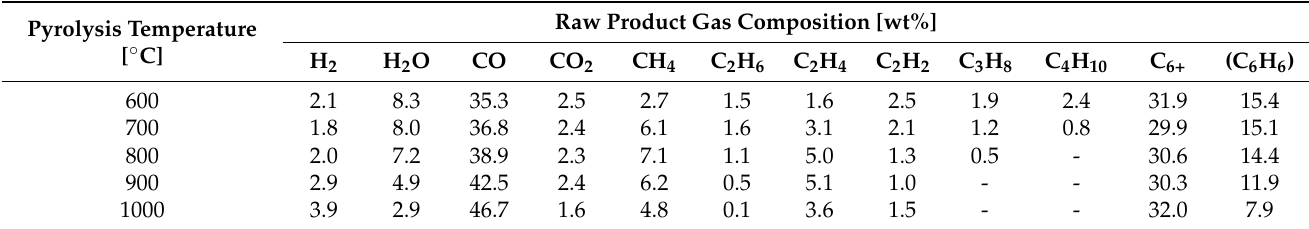
Table 4. Characterization of the product composition for numerical calculations—raw pyrolytic gas, residence time 2 s, fuel ASR 1.